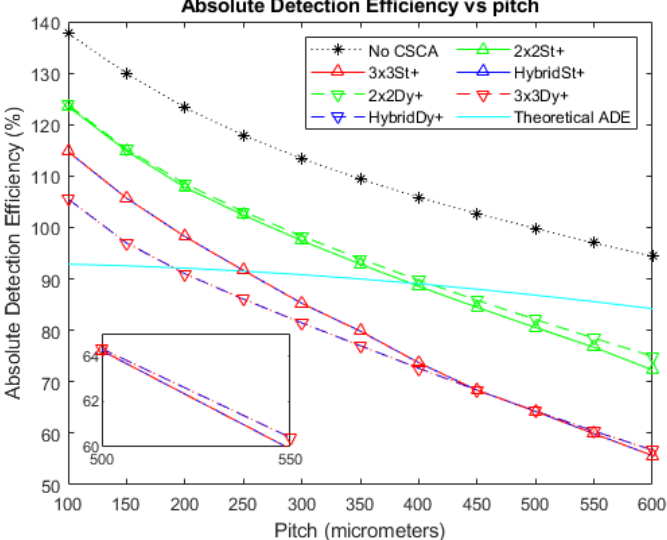
Figure 4. A plot of ADE versus pixel pitch at an incident photon flux of 10 7 photons mm −2 s −1 . The Hybrid and 3 × 3 CSCAs perform indistinguishably according to this metric, resulting in significant overlap. Figure inset shows that the dynamic and static CSCAs swap order at the highest pitches considered in this figure. The case where no CSCA is applied is also shown, along with the theoretical ADE value proposed earlier as a reference.